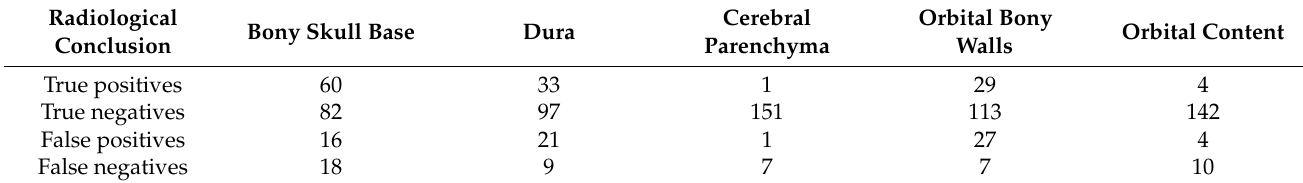
Table 4. Radiological